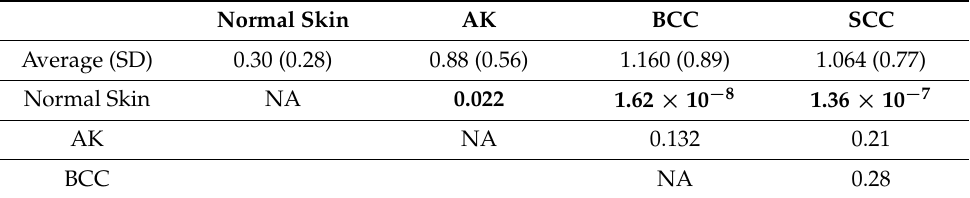
Table 3. Statistical analysis for p -values for VOCT measurement for ratios for weighted displacement peak heights in m for audible sound frequency of 80 Hz/100 Hz *. The sample size is the same as in Table 1 for each group.